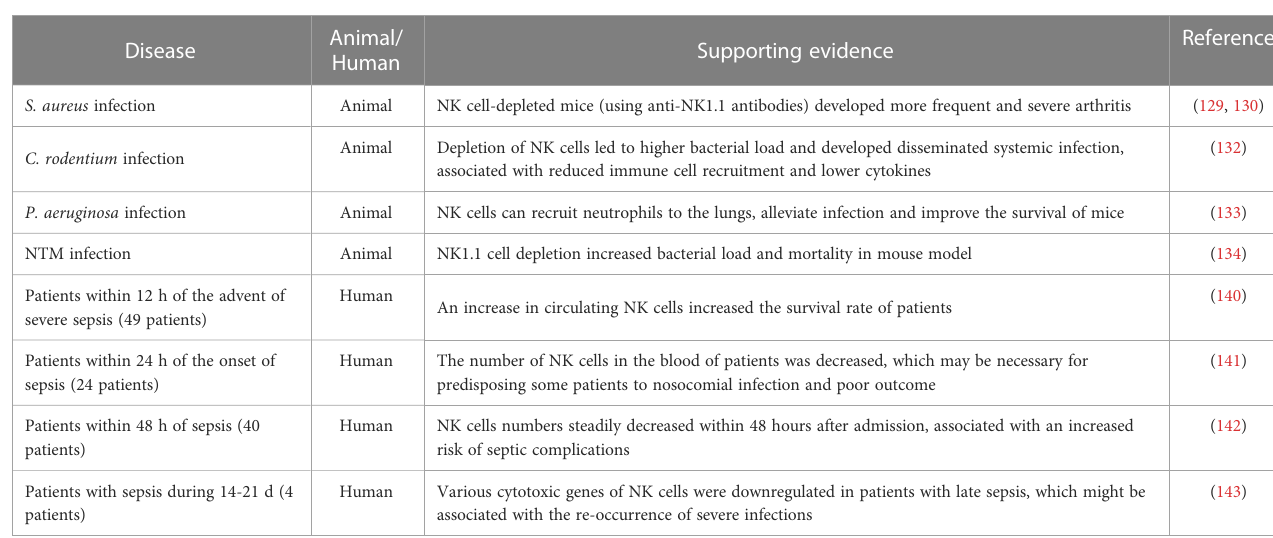
TABLE 2 Summary of the protective roles of NK cells in